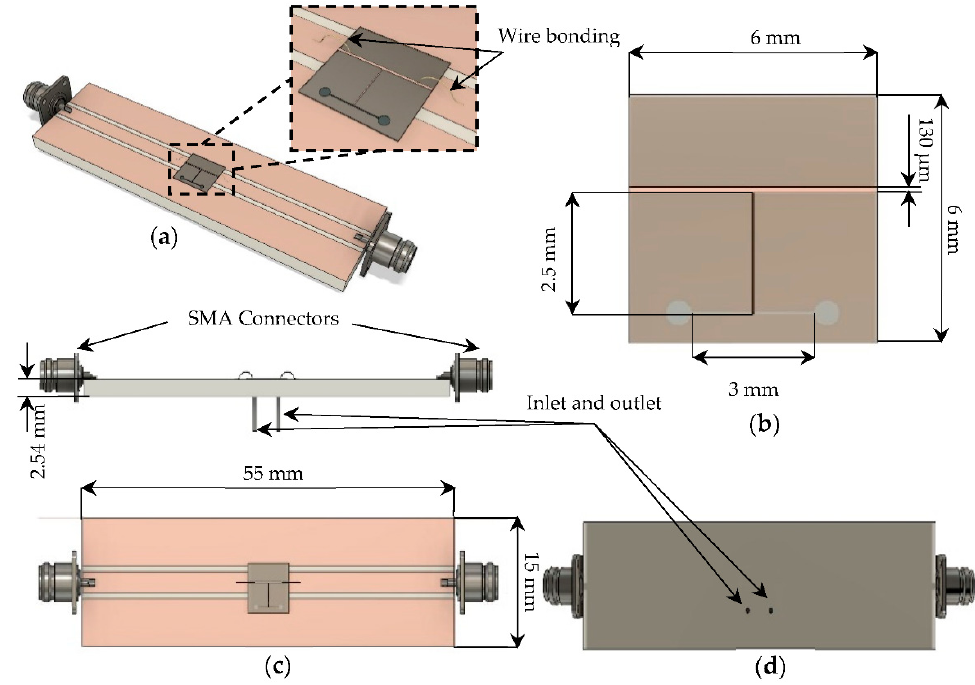
Figure 4. The model of the fully assembled biosensor to the carrier: ( a ) Close up of the microfluidic biosensor wire bonded to the carrier; ( b ) Top view of the microfluidic biosensor showing its dimensions; ( c ) Top view and lateral view of the fully assembled biosensor to the carrier showing the dimensions of the carrier; ( d ) Bottom view of the carrier showing the structure of liquid injection accesses.